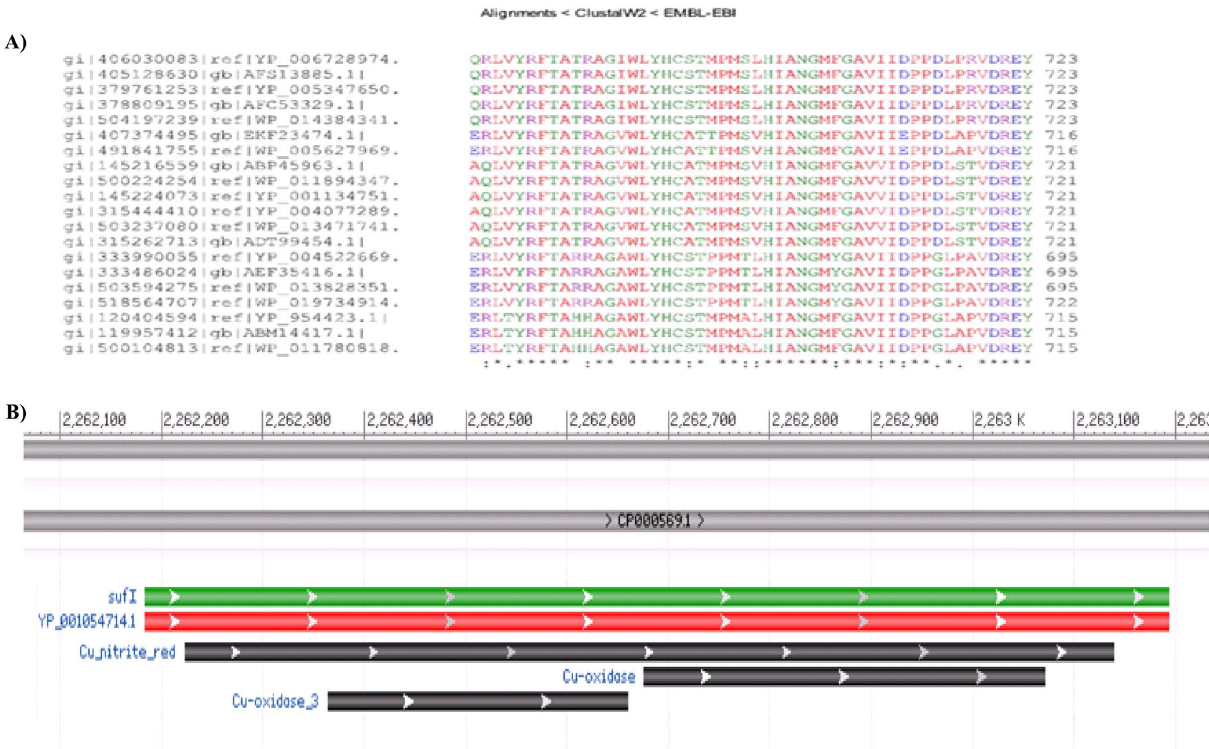
Figure 2. ( A – B ) Identification of conserved domains of genes in Mycobacterium tuberculosis ( A ) Conserved sequences obtained after alignment of gene sequences coding for nitrite reductase of different bacteria by ClustalW2 software (http:// www. ebi. ac. uk/ Tools/ msa/ clust alo/). ( B ) Gene sequences containing conserved domain Cu-oxidase and Cu-oxidase-3 of Mtb H37Ra nitrite reductase. Data was extracted from CD search software.